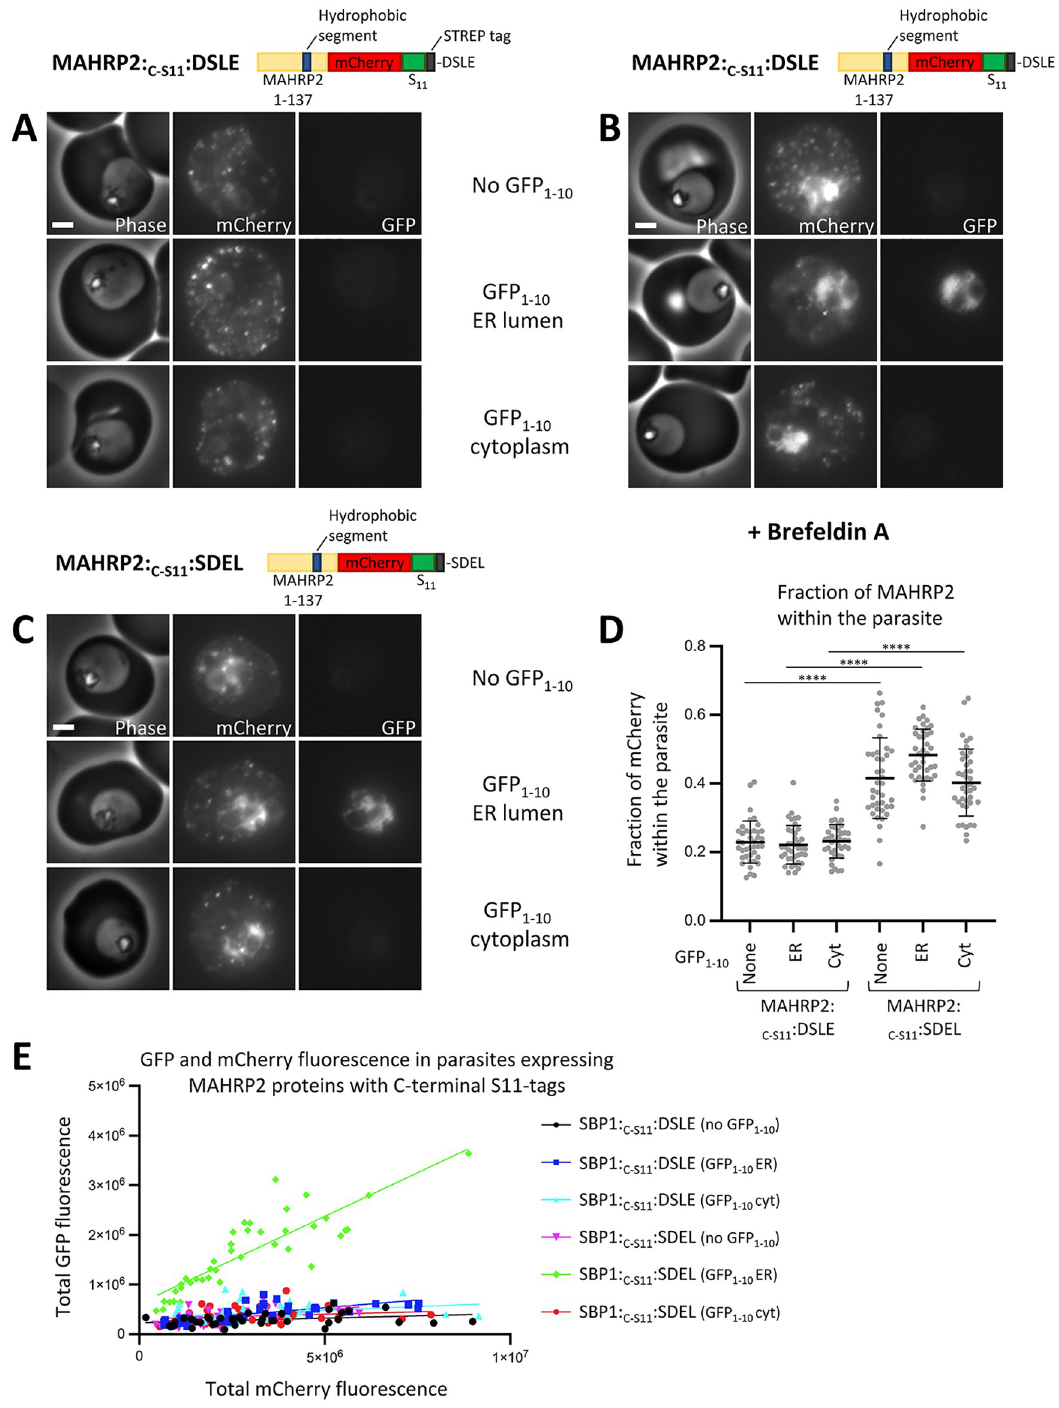
Fig 6. ER-lumenal location of the C-terminus of MAHRP2. (A) Phase contrast and fluorescence images of parasites expressing the indicated proteins are shown. Proteins were expressed alone, co-expressed with ER-lumenal GFP 1-10 or cytoplasmic GFP 1-10 , as indicated. (B) Images of parasites expressing MAHRP2: C-S11 :DSLE expressed alone, co-expressed with ER-lumenal GFP 1-10 or cytoplasmic GFP 1-10 , as indicated. Parasites were treated with 1 μ g/ml Brefeldin A for four hours prior to imaging. (C) Images of parasites expressing MAHRP2: C-S11 :SDEL and the indicated GFP 1-10 proteins, are shown. Scale bar: 2 μ m. (D) The fraction of total mCherry fluorescence located within the parasite is shown for each parasite line expressing the indicated MAHRP2 and GFP 1-10 proteins. Forty individual trophozoite stage parasites, from four independent experiments, were analysed for each parasite line. Data